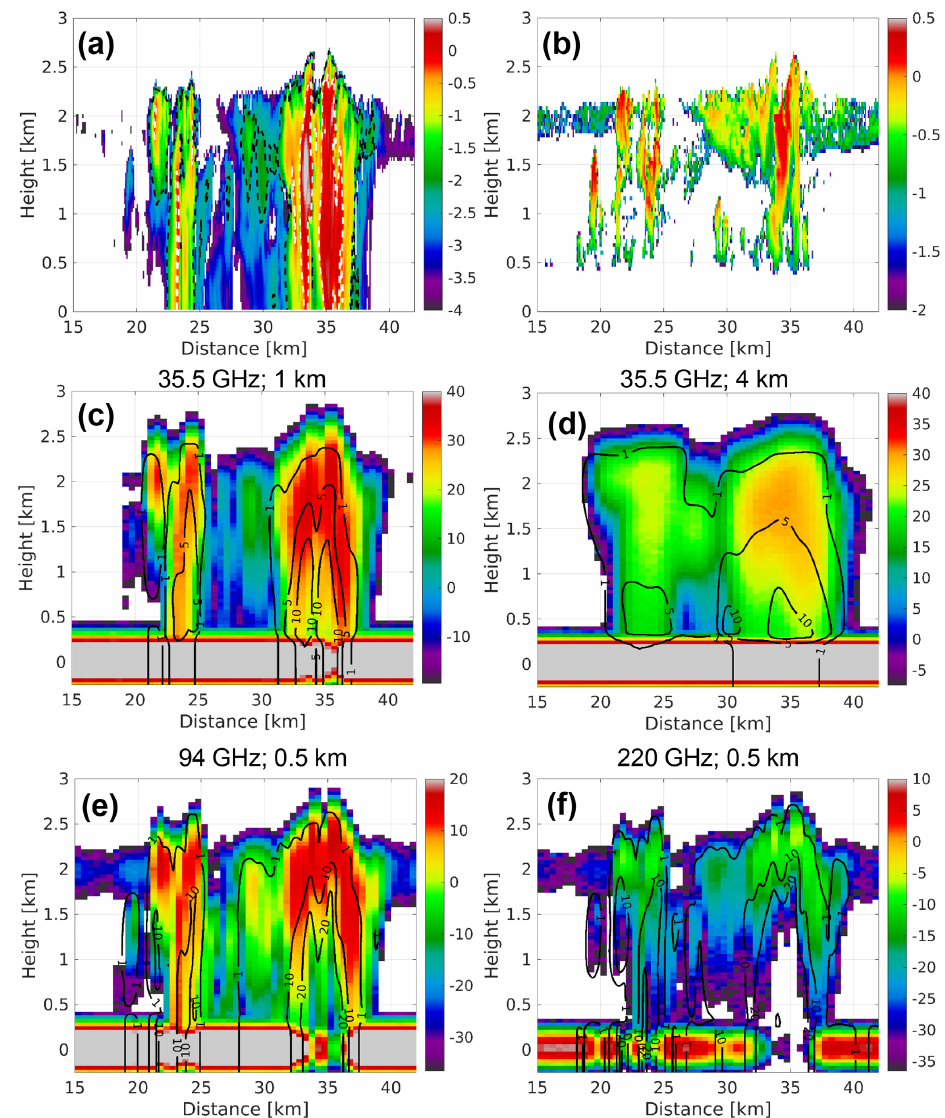
Figure 8. (a) Vertical profile of r-LWC (rain liquid water content) for the cross section corresponding to the black line shown in Fig. 5 at the model resolution (100m); the dashed black and white lines correspond to D m equals 0.5 and 1.5mm, respectively. (b) Vertical profile of c-LWC (cloud liquid water content) for the same cross section. The units of the color bar for both (a) and (b) corresponds to log 10 of LWC in grams per cubic meter; so for instance − 1 means 0.1gm − 3 . (c–g) Simulated vertical profiles of reflectivities (color bar units: dBZ) for bands and horizontal resolutions as indicated in the text at the top each panel. Black lines correspond to contour levels of the antenna-weighted PIA from the top of the